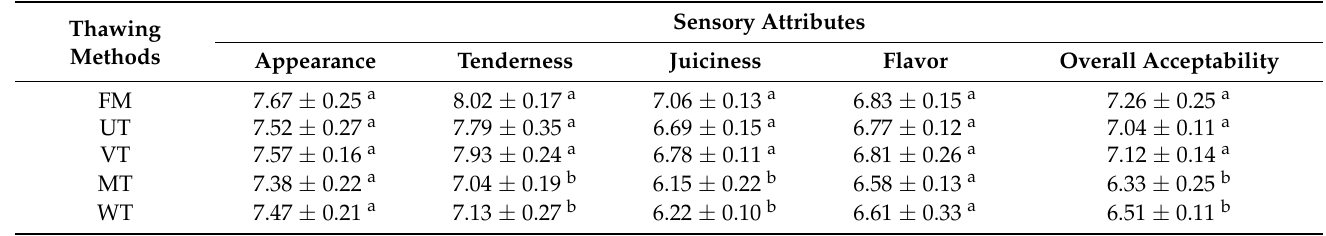
Table 6. Sensory characteristics of cooked porcine longissimus dorsi induced by thawing methods.